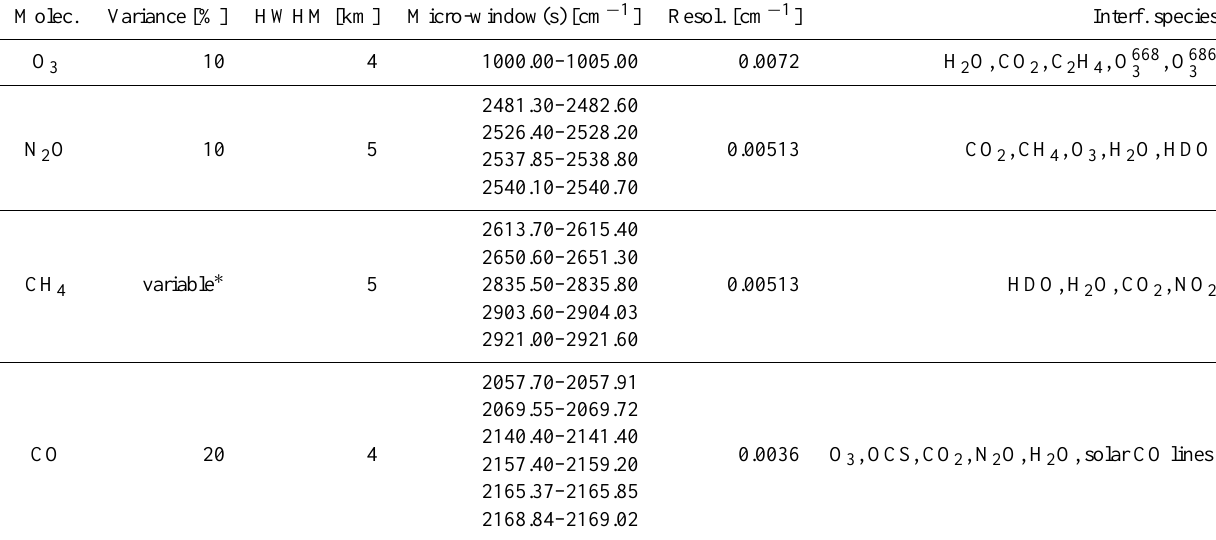
Table 1. Retrieval characteristics for each target species, for the 2007 FTIR campaign at Ile de La R´eunion. The variances represent the diagonal elements of S a and HWHM the applied inter-layer correlation length of a Gaussian probability distribution. The last three columns list the spectral micro-windows that are fitted simultaneously, the associated spectral resolution (depending on the optical filter and on the target gas), and the main interfering species, respectively.